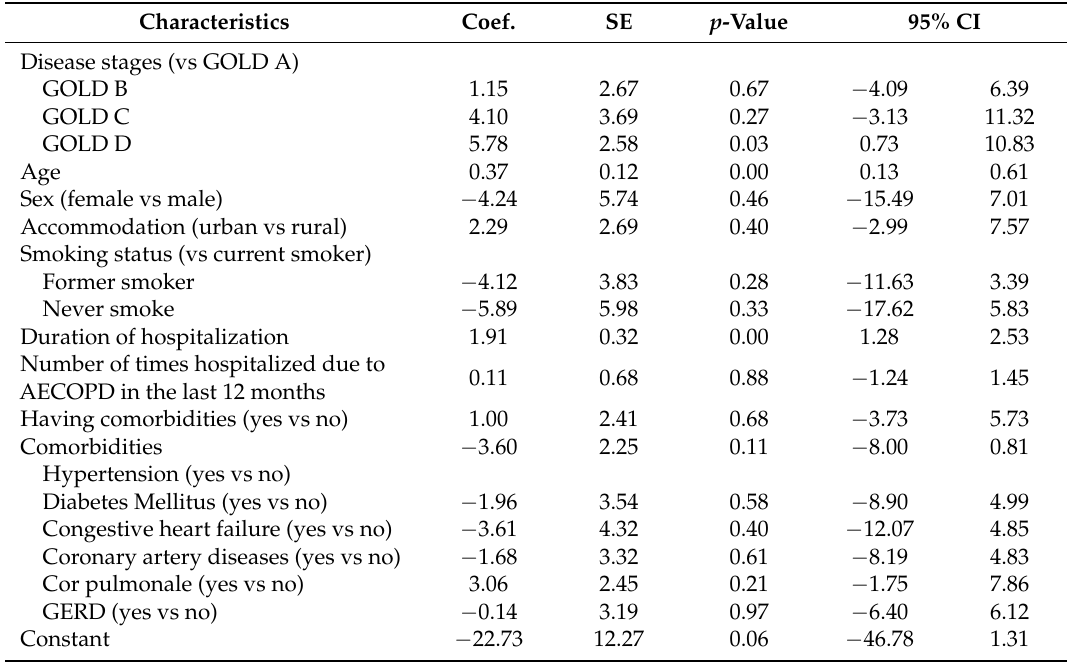
Table 3. Associated factors with AECOPD hospitalization